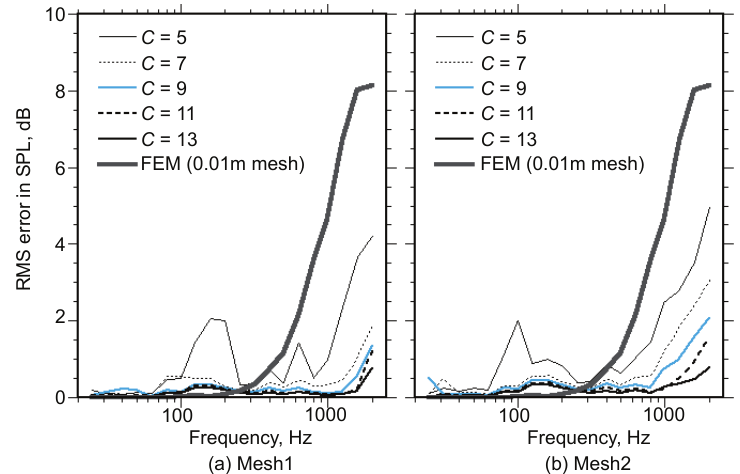
Figure 6. Comparison of RMS error for ( a ) Mesh 1 and ( b ) Mesh 2. An FEM result obtained using 0.01 m mesh is also shown for comparison.